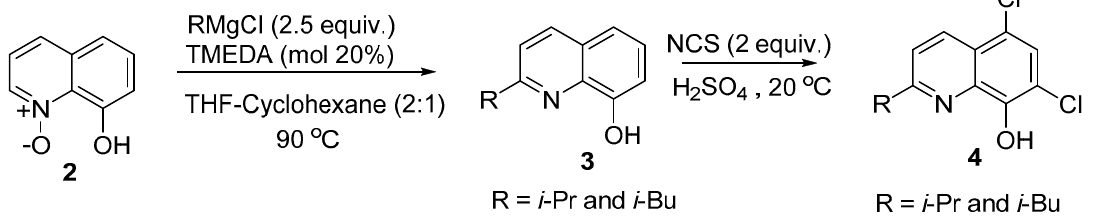
Molecules 2020 , 25 , x FOR PEER REVIEW 2 of 26 Figure 1. Reaction sites of 8-hydroxyquinoline 1 . 8-Hydroxyquinoline has attracted the attention of chemists, medicinal chemists, and people in health sciences due to its unique physical and chemical properties. The interest in this compound and its derivatives has increased considerably in the last two decades [3]. 8-Hydroxyquinoline and many of its derivatives have a wide range of pharmacological applications, e.g., as iron-chelators for neuroprotection, as anticancer agents, as inhibitors of 2OG-dependent enzymes, as chelators of metalloproteins, as anti-HIV agents, as antifungal agents, as antileishmanial agents, as antischistosomal agents, as mycobacterium tuberculosis inhibitors, and as botulinum neurotoxin inhibitors [4]. Furthermore, these compounds are used as electron carriers in organic light-emitting diodes (OLEDs) and as fluorescent chemosensors for metal ions [5,6]. On the basis of the preceding discussion, and owing to the importance of 8-HQ from a chemistry point of view and to the wide range of biological activities and pharmacological applications of 8-HQ and derivatives, this review focuses on current knowledge of the synthetic methods of novel derivatives, along with the derivatives’ biological activities and medicinal applications. In addition, this review summarizes the most recent literature pertaining to the synthesis and bioactivity of 8-HQ and its derivatives, covering the period ranging from 2017 to the present. In addition, structure–activity relationships (SARs) of these derivatives are discussed to provide directions for further development of novel 8-HQ-based bioactive agents. For this purpose, recent relevant references have been obtained from different databases, such as Medical Literature Retrieval Analysis and Retrieval System Online (MEDLINE) (PubMed), Google Scholar, Science Direct, Scopus, Cochrane, SID, and SciFinder. Our intention is that the content and organization of this review will be valuable to the field and will greatly help researchers. Below are details about the recent documented synthesis methods of 8-HQ and its derivatives, as well as their biological activities against different diseases and disorders. 2. Antiviral Activity Due to the Coronavirus 2019 ( COVID-19) pandemic and its devastating economic, social,